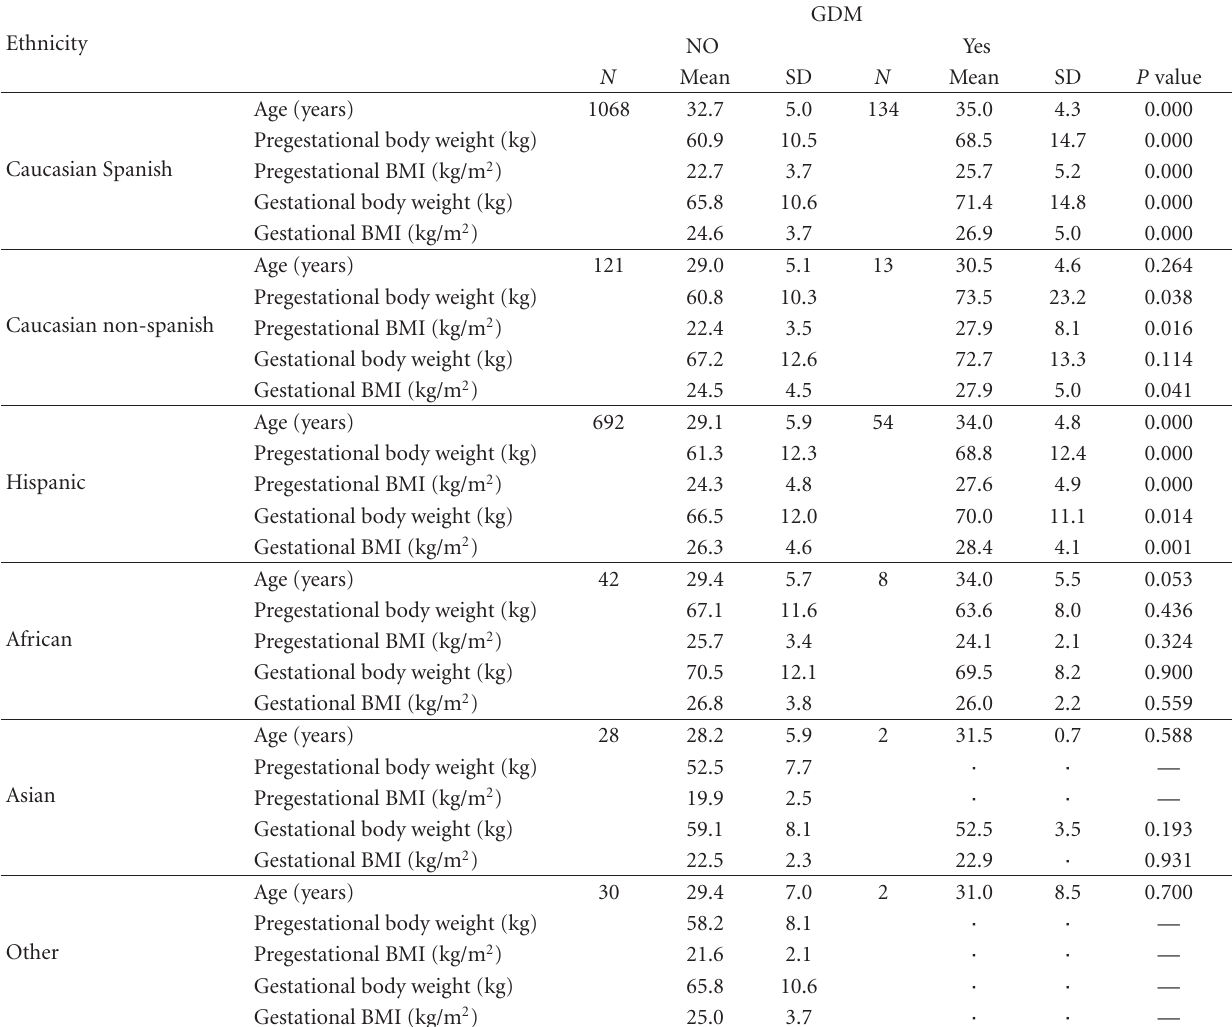
Table 1: Demographic and anthropomorphic characteristics of the 2194 women enrolled in the study, according to diagnosis of GDM. Ethnicity